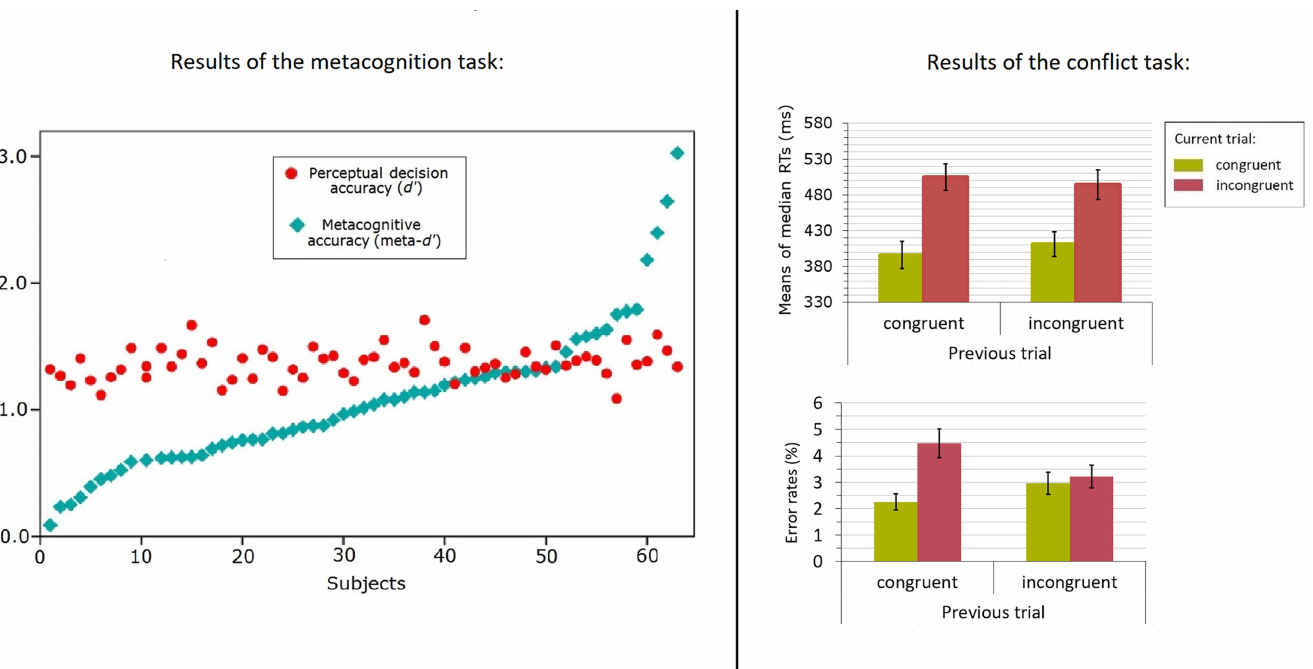
Fig 3. Left : Scatterplot of metacognitive accuracy (meta- d’ ; blue diamonds), and primary task performance ( d’ ; red dots). The data were arranged by augmenting meta- d’ values. Right : 2 × 2 factorial plots of the conflict task, separately for the means of the median RTs (above), and the means of the error rates (below), for each condition defined by congruency and previous congruency. Error bars reflect the 95% confidence intervals for the means.